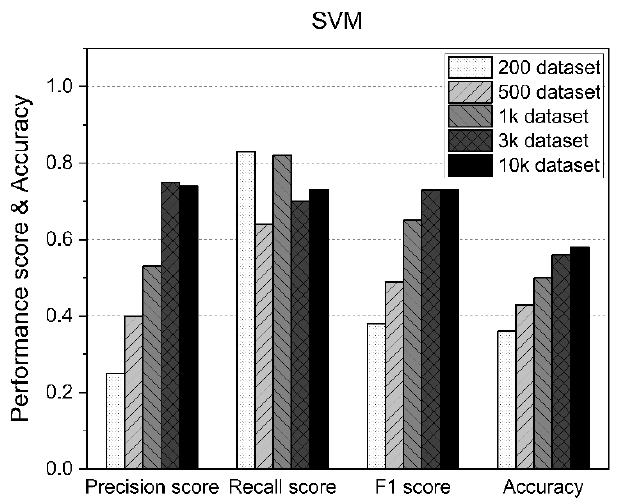
Figure 8. SVM performance results according to the size of the dataset.